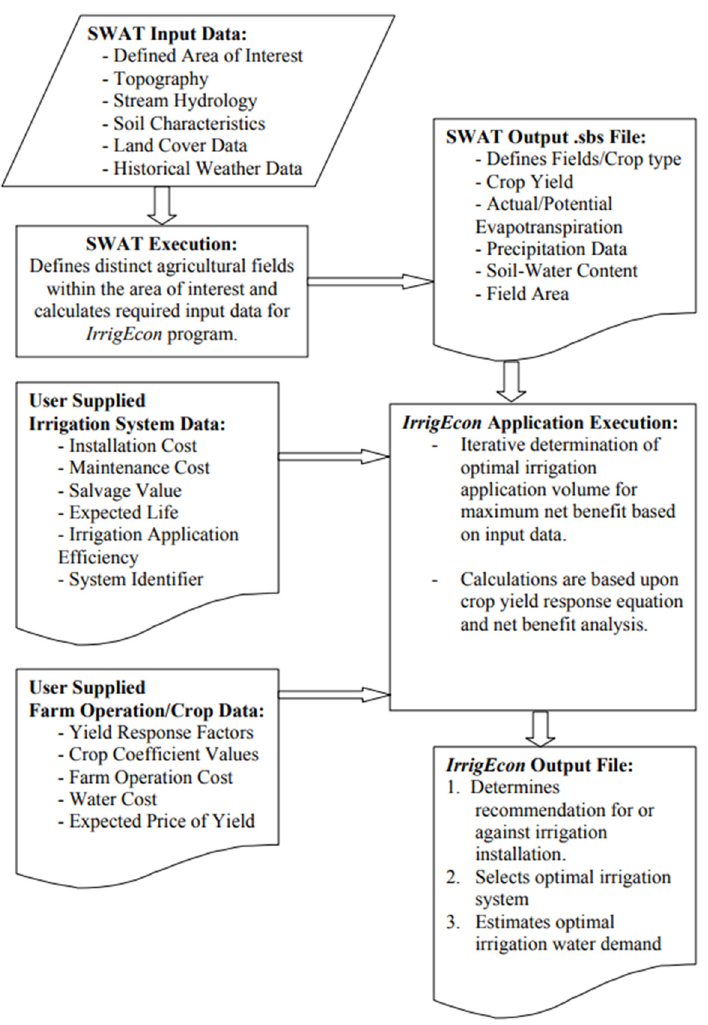
Figure 1. General overview of the SWAT-IrrigEcon model showing the required model inputs and selected outputs.